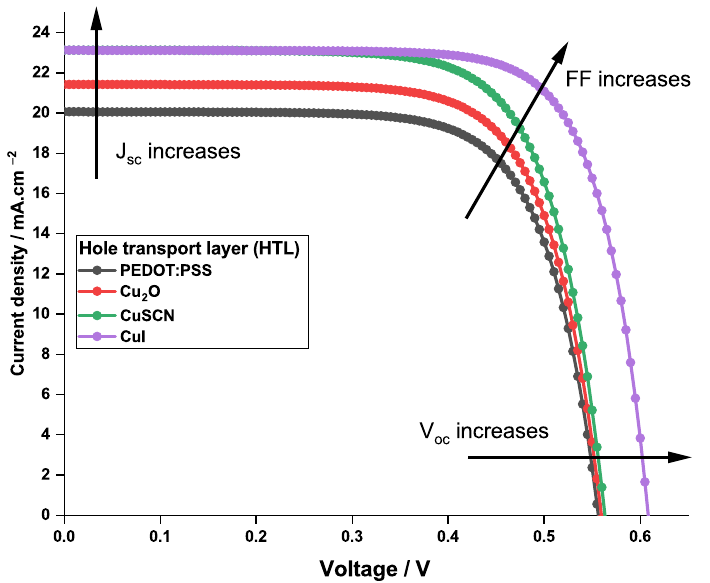
Figure 4. Current density—voltage characteristics for the PSCs with different HTL materials.